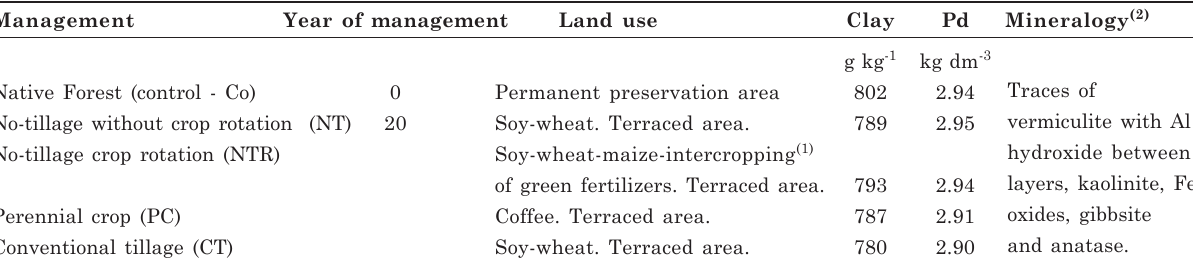
(1) Intercropping of black oat ( Avena strigosa ) + hairy vetch ( Vicia villosa ) and + white radish ( Raphanus sativus ) for residue incorporation into the soil. (2) X-ray diffractograms made at the French Agronomic Institute (INRA - Versailles) of the non- ferrous B wc horizon clay fraction that was saturated with Mg, Mg + ethylene glycol and K heated to 350 ºC and 550